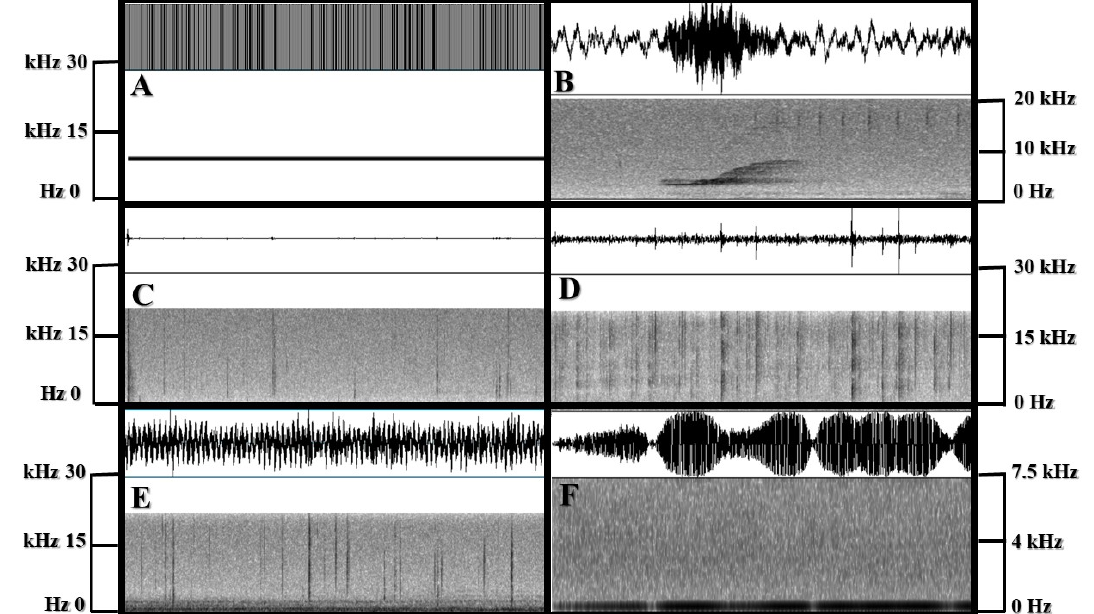
Figure 3. Spectrograms of Playback Sounds (Hz). Except for the 10 kHz Control B tone (1 s), all